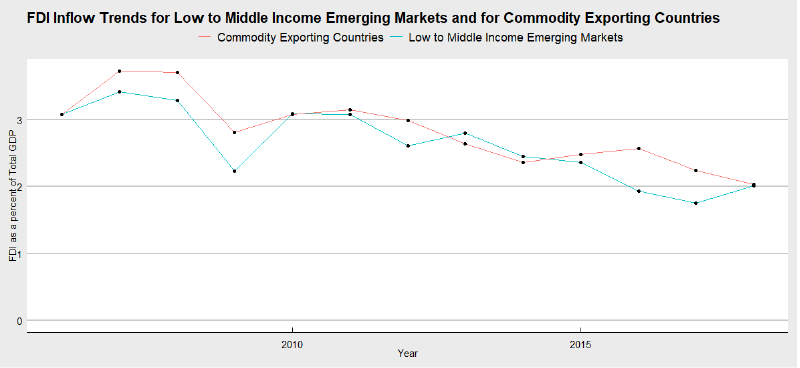
Figure 3. FDI as percent of GDP for emerging markets and commodity exporters.